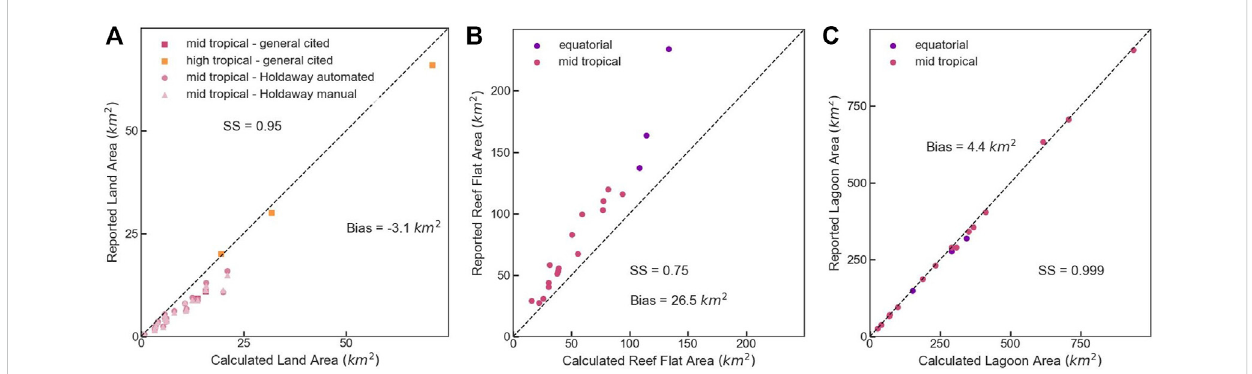
FIGURE 11 Validationofper-atollmorphometricscomparingcalculatedtopreviouslyreportedmorphometricsfor (A) totallandarea, (B) totalreef- fl atarea,and (C) total lagoon area with calculated Skill Score (SS) and Bias and 1:1 line (black